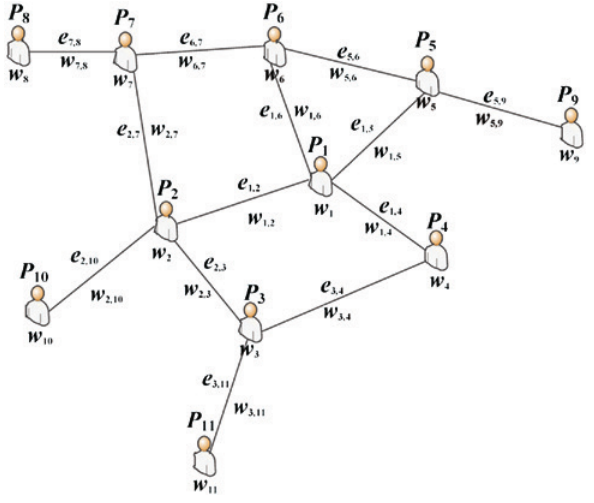
Figure 2: Example of Undirected Weighted Network of